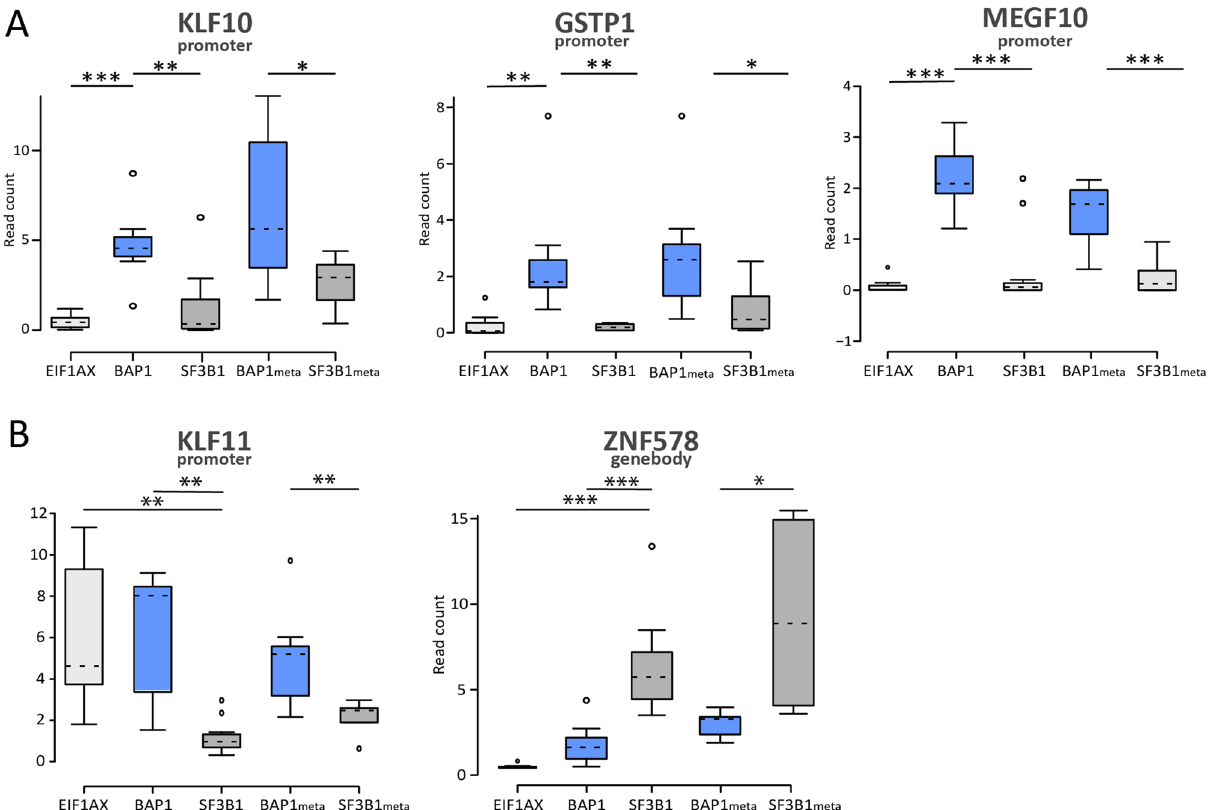
Figure 4. Boxplots showing the normalized read count level, which indicates the level of methylation, for ( A) Differentially methylated genes in BAP1-mediated metastasis. ( B) Differentially methylated genes in SF3B1- mediated metastasis. Significance differences between the groups are indicated on the top. *P < 0.05, **P < 0.01, ***P <